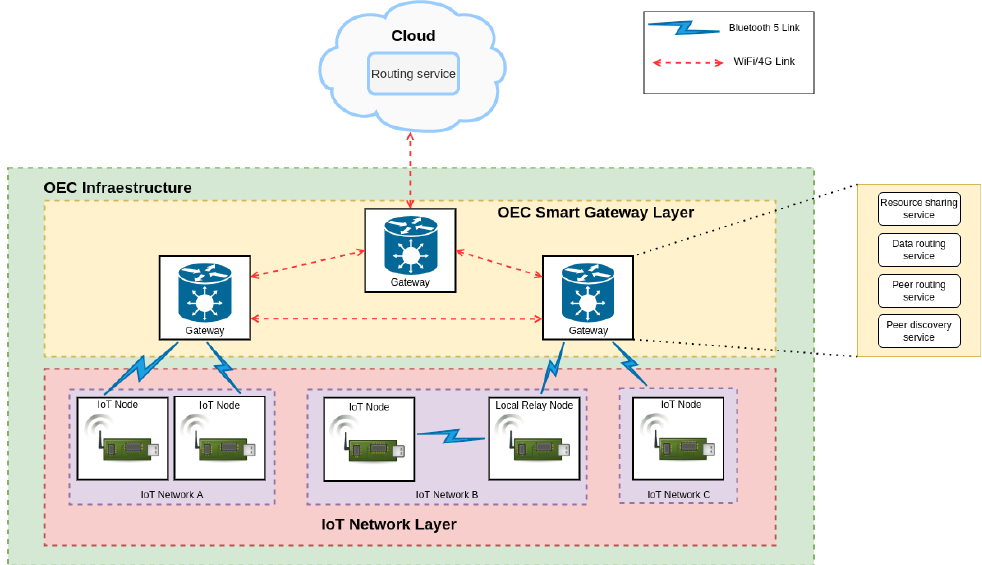
Figure 3. Implemented OEC communications